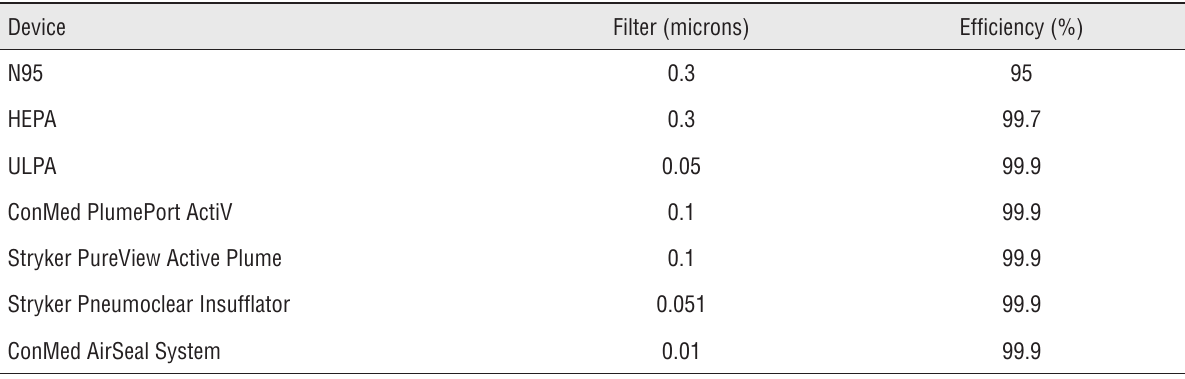
Table 2 - Filtration devices for laparoscopy and robotics.